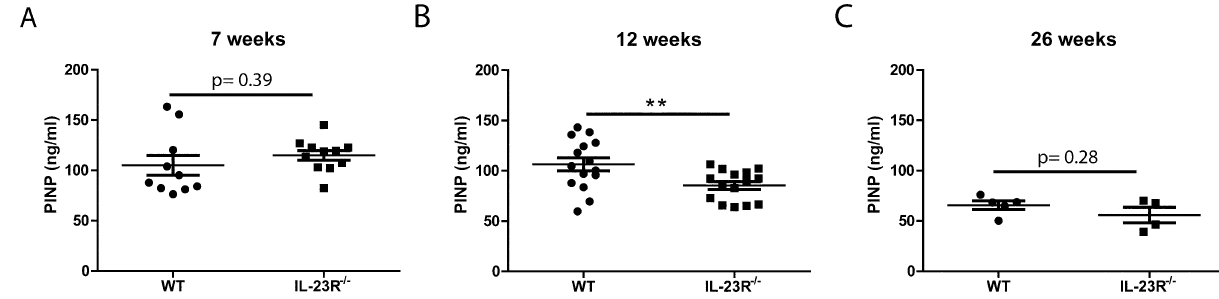
Figure 6. Serum PINP is significantly lower in 12-week-old IL-23R −/− mice compared to WT. Serum PINP was measured in ( A ) 7-week-old, ( B ) 12-week-old or ( C ) 26-week-old WT and IL-23R −/− mice. Pooled data of n = 10–11 7-week-old mice (three independent experiments), n = 15 12-week-old mice (four independent experiments) and n = 4–5 26-week-old mice (one experiment). Data are depicted as mean ± SEM. ** p < 0.01.